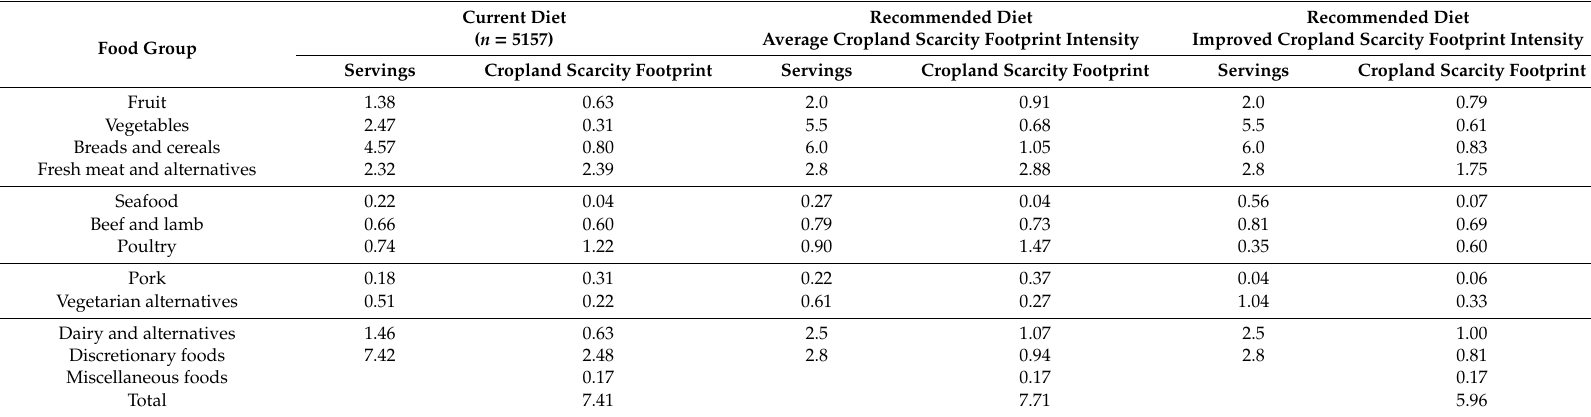
Table 3. Food intake (servings person − 1 ) and cropland scarcity footprint (m 2 yr-e person − 1 ) for the current and recommended Australian adult (19–50 years) daily diets 1 . Current Diet ( n = Food Group